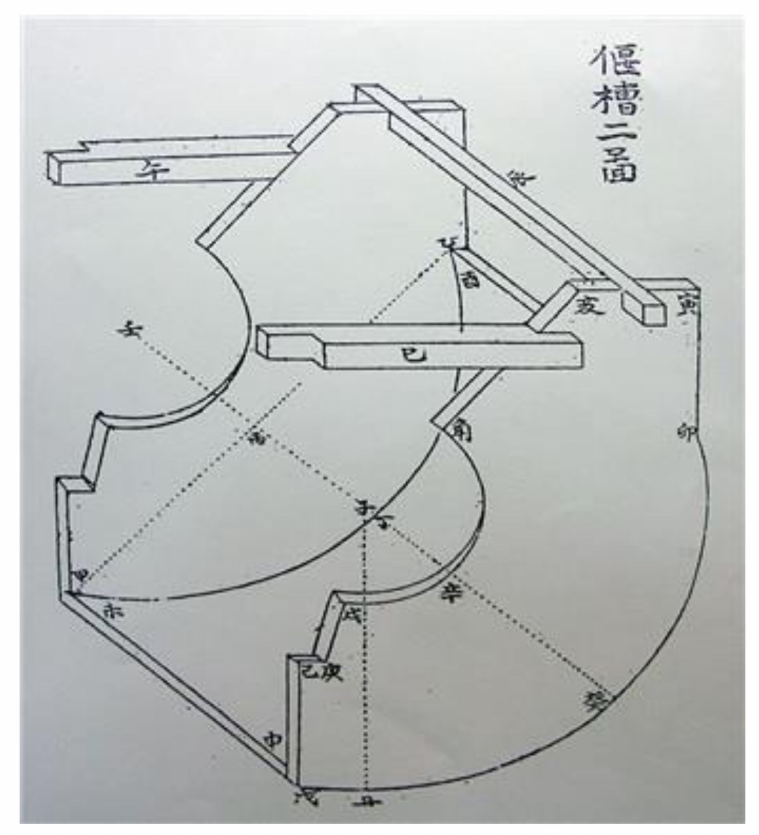
Figure 2. Jasungcha Dohae Eonjo.